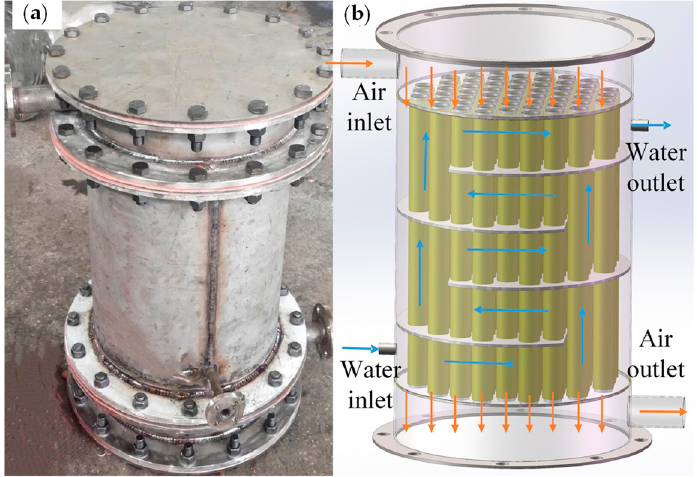
Figure 30. The illustration of shell-and-tube thermochemical reactor: ( a ) real reactor, ( b ) internal structure and flow direction [270]: Reprinted with permission from Ref. [270] Copyright © 2021 Elsevier Ltd. All rights reserved.